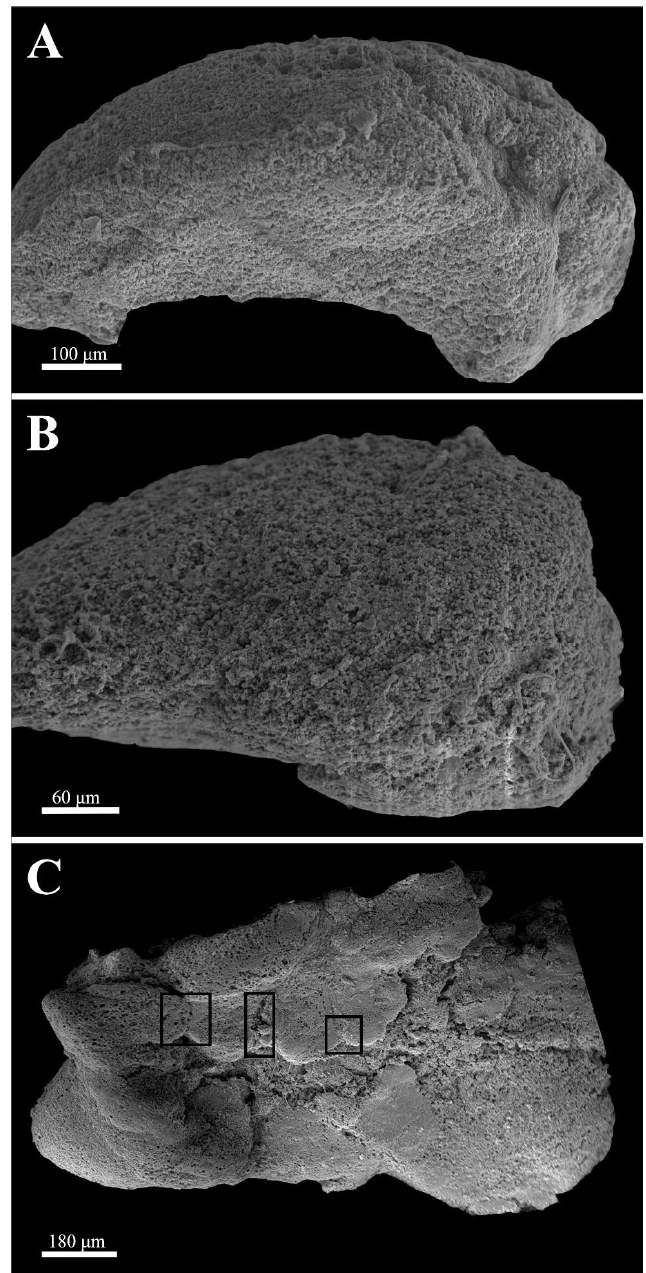
Figure 1. Scanning electron micrographs of three surviving samples representing three time points in culture. At 24 h ( A ), all structural characteristics of the zebrafish optic tectum could be recognized. At 48 h ( B ), only the ependymal layer was recognizable as a distinct morphological entity but the whole surface tectal piece was covered with densely packed round cells. At 96 h ( C ), symmetrical protrusions of regenerating tissue formed on the surface of the explant. These structures usually have a midline, a raphe-like groove (black boxes) that divides the formations into two mirrored halves.